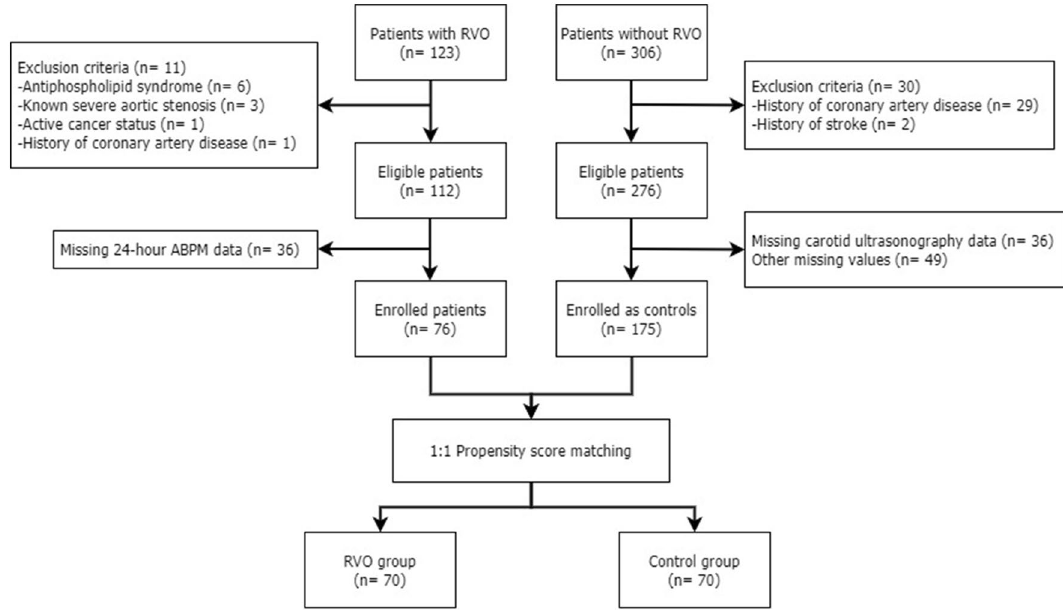
Figure 1. Schematic depiction of the selection process of the study